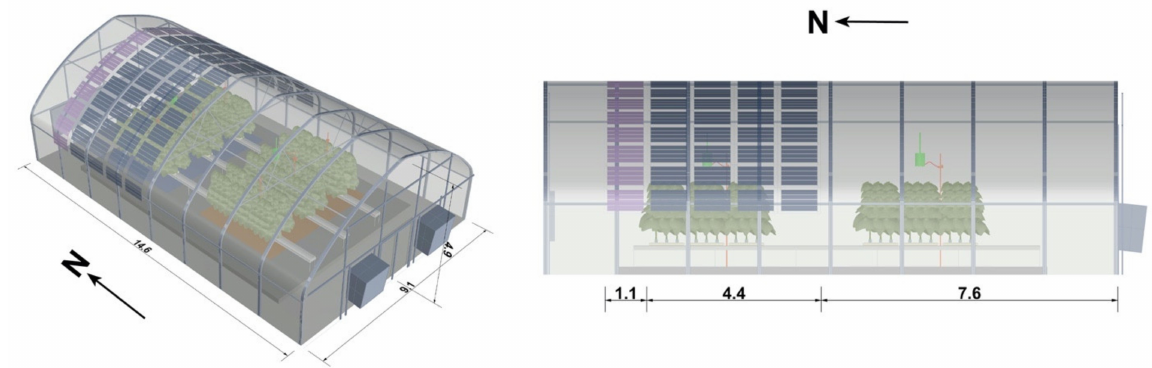
Figure 1. 3-D schematic of the study greenhouse from the southwest view ( left ) with the organic photovoltaics (OPV) shade element installed on the northern section of the greenhouse roof; the view from the west side of the greenhouse ( right ) shows the position of the OPV shade element; two additional OPV arrays (shown in pink) were installed on 11 June 2020. Dimensions are in